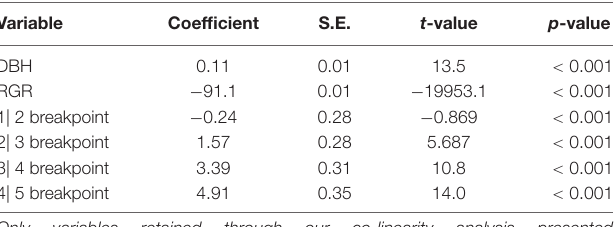
TABLE 1 | Parameters of an ordinal logistic regression model predicting beech bark disease (BBD) severity as a function of tree diameter (DBH) and relative growth rate (RGR).